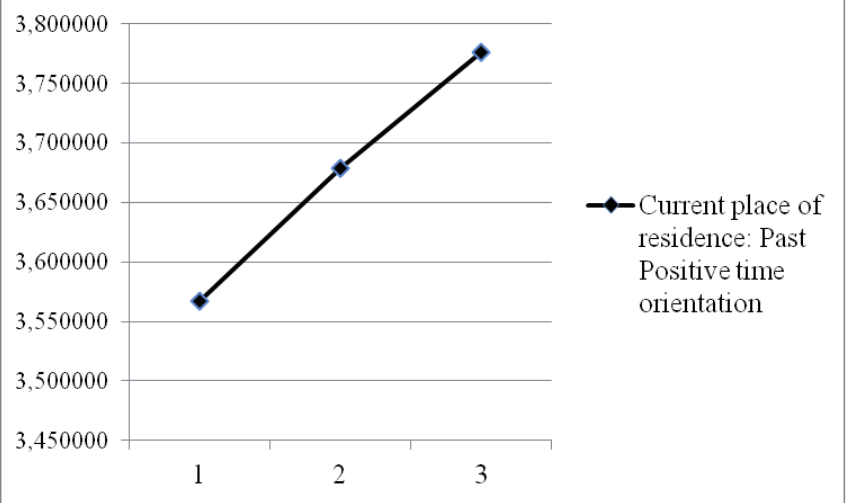
Fig. 2. Average values according to the scale „Past Positive” in subgroups divided on the basis of current residential places: 1 – residents of oblast centres (n = 386), 2 – town residents (n = 55), 3 – residents of villages and town-like settlements (n = 70). Source: Prepared by author (own